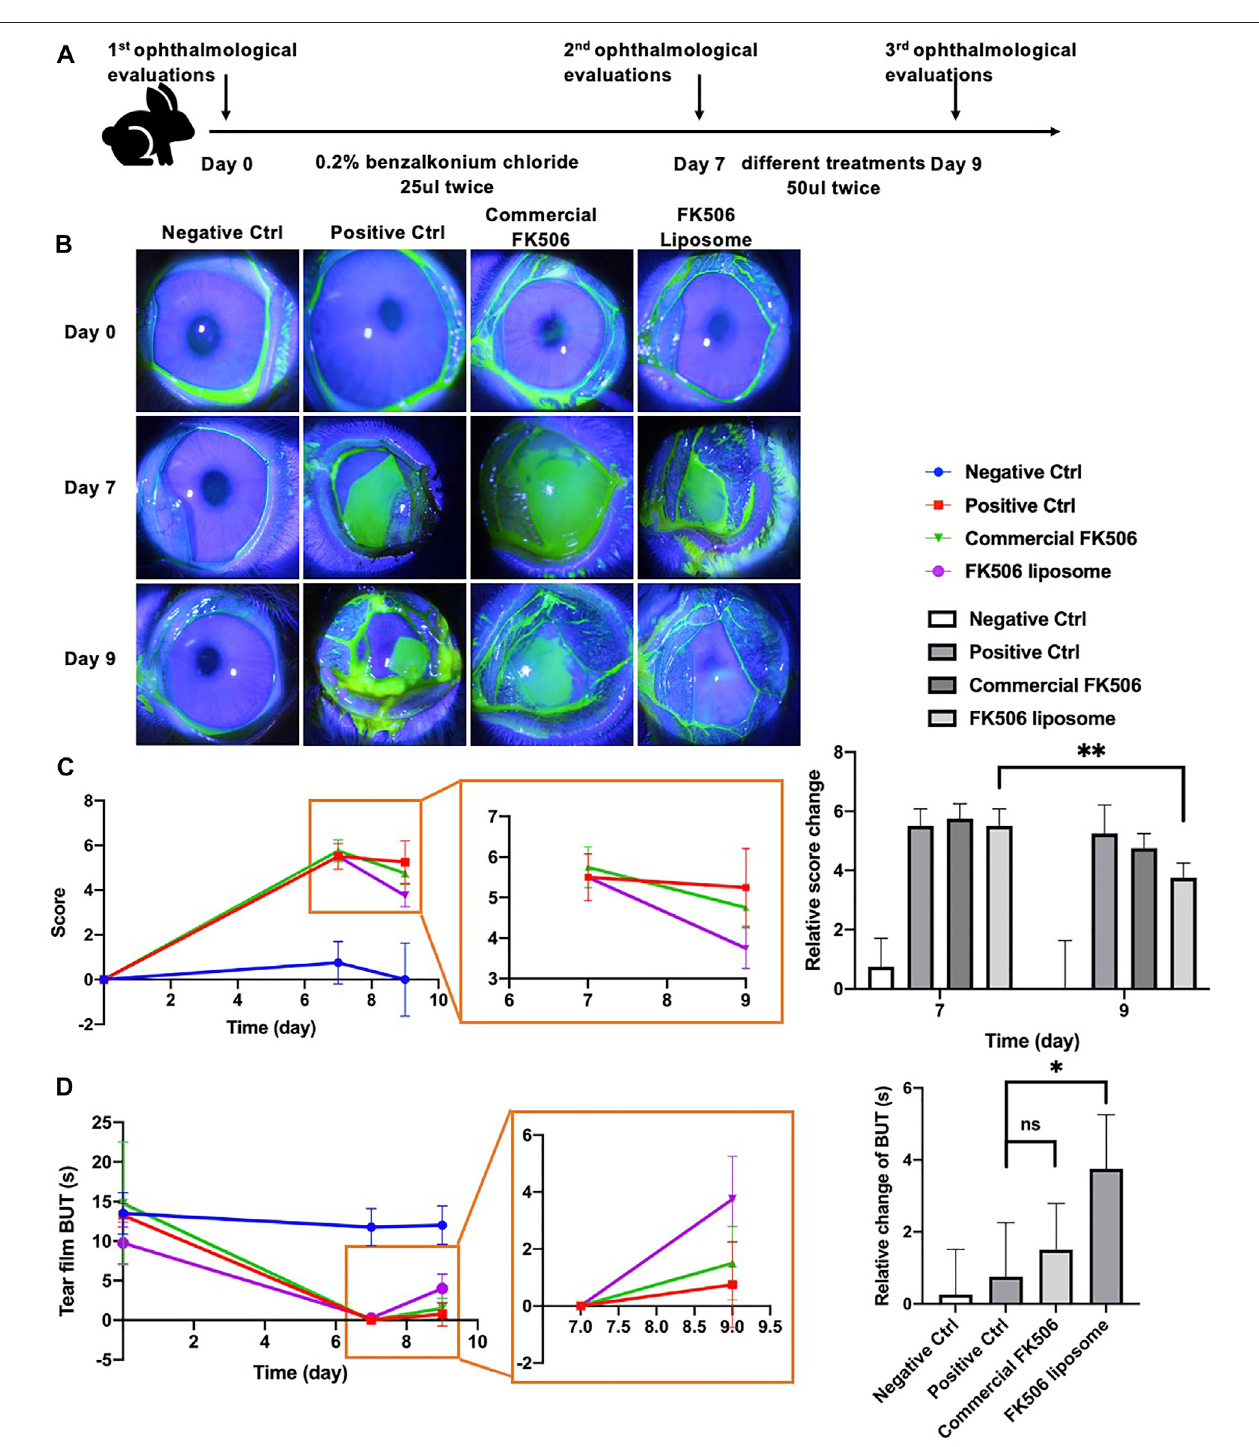
FIGURE 5 | In vivo ophthalmological evaluations of FK506 liposomes in New Zealand rabbits with dry eye. (A) Flow diagram of the dry eye model and treatment plan. (B) Representative slit-lamp images of corneal fl uorescein sodium stainingat day 0, day 7, and day 9. (C) Relative corneal fl uorescein staining score change at day 0, day 7, and day 9 (left); partial enlarged image (middle) and quantitative analysis of relative changes of score compared with baseline (day 0) (right). (D) Absolute BUT change at day 0, day 7, and day 9 (left); partial enlarged image (middle) and quantitative analysis of relative changes of BUT compared with day 7 (right). * p < .05 and ** p <